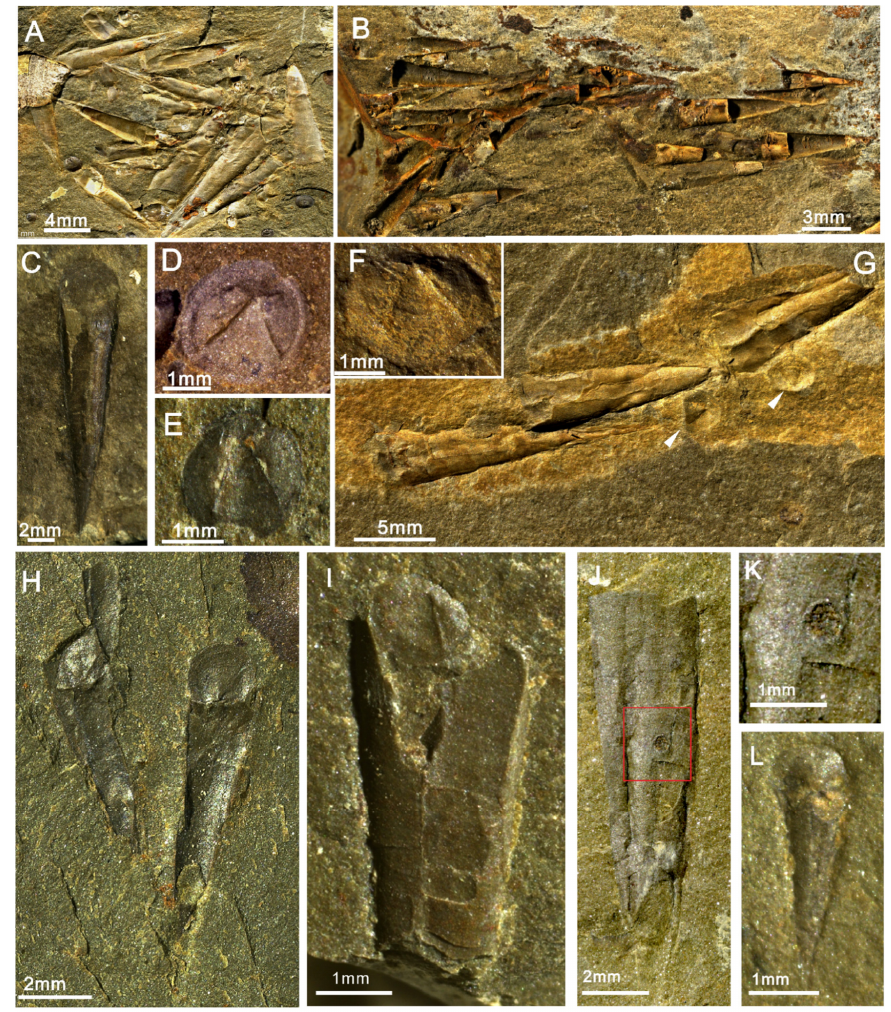
Figure 2. Hyolith Doliutheca orientalis from the Shipai Formation of the Xiachazhuang section, Hubei Province, China. ( A , B ) Concentrations of Doliutheca orientalis . ( A ) ELI QJP-SP-H-125. ( B ) ELI QJP-SP-H-167. ( C ) The ventral view of Doliutheca orientalis showing the arch-shaped ligula. ELI QJP-SP-H-293. ( D – F ) the rounded opercula of Doliutheca orientalis , showing the X-shaped imprint of strongly developed clavicles and cardinal process. ( D ) ELI QJP-SP-H-128. ( E ) ELI QJP-SP-H-343. ( F ) ELI QJP-SP-H-067. ( G ) Three individual conchs of Doliutheca orientalis with associated opercula. ELI QJP-SP-H-067. ( H – I ) Doliutheca orientalis with articulated operculum. ( H ) ELI QJP-SP-H-368. ( I ) ELI QJP-SP-H-382. ( J ) Hyolith conch with possible predatorial borehole or the trace from an epizoan/epicole. ELI QJP-SP-H-009. ( K ) The close-up view of hole in ( J ). ( L ) The dorsal view of hyolith operculum showing distinct cardinal shield and conical shield. ELI